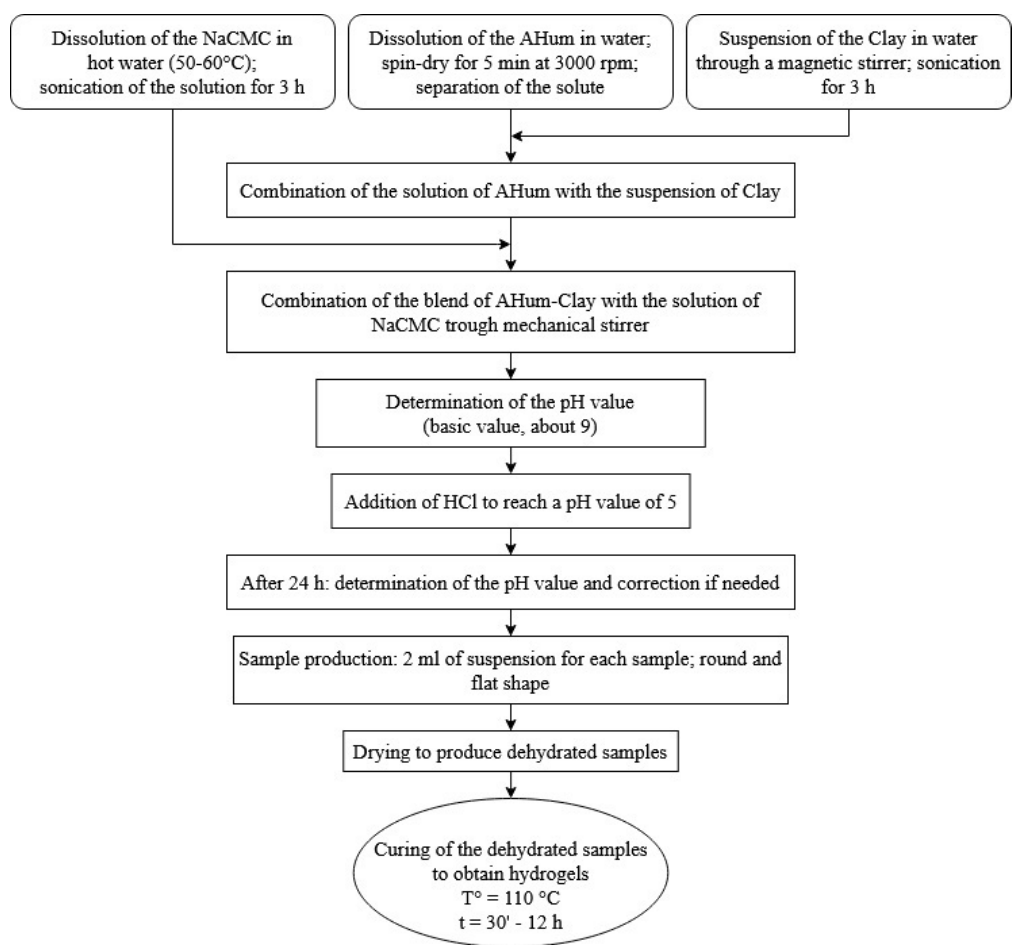
Figure 1. Flow diagram for the preparation of the hydrogels.